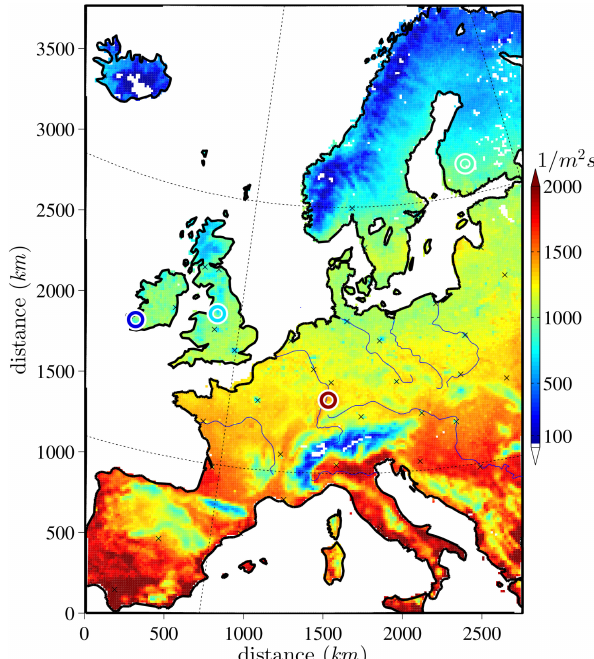
Figure 9. Average simulated FBAP emission flux ( F FBAP ) in m − 2 s − 1 from 26 August to 1 September 2010 (excluding a spin-up period of 6h). Circles indicate the locations of the different FBAP measurement time series and the color within the white circles rep- resents the mean emission flux calculated from FBAP measure- ments at each